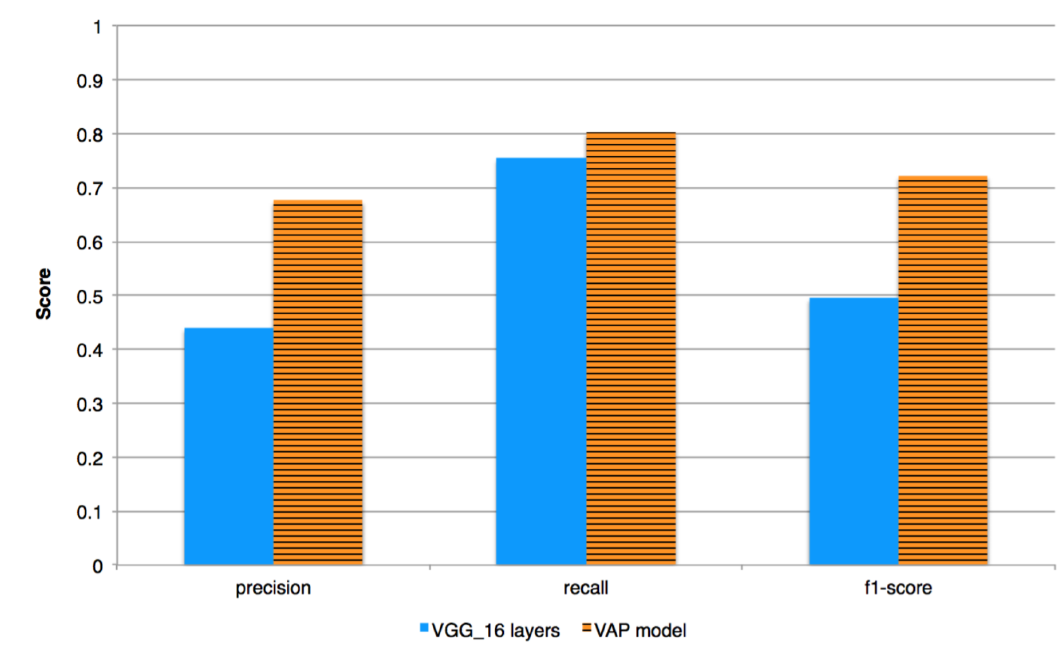
Figure 9. Overall comparison between using the complete VAP model and using only the bottom-up pathway (VGG16). Precision, recall, and F1-score are